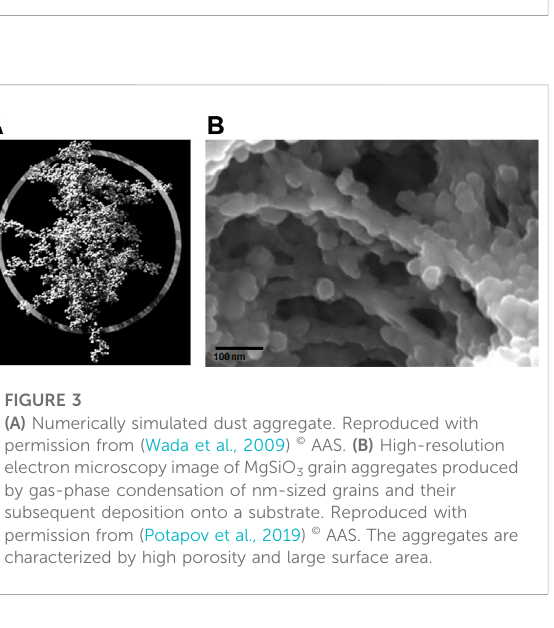
FIGURE 2 (A) Temperature-dependent re fl ection spectra of the enstatite sample. Reproduced with permission from (Zeidler et al., 2015) © AAS. (B) IR spectra of amorphous and crystalline (annealed at 1150 K) magnesium silicate grains. Reproduced with permission from (Sabri et al., 2014) © AAS.